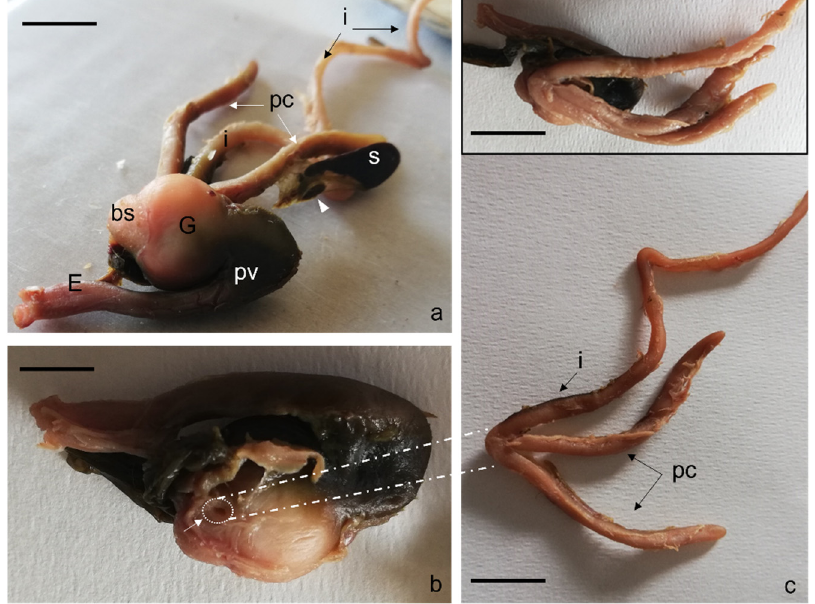
Figure 4. Gross anatomy. ( a ) Photograph of the right side of the gastrointestinal tract: esophagus (E), proventriculus (pv), gizzard (G), cranioventral blind sac (bs), spleen (s), accessory or supernumerary spleen (arrowhead), pyloric appendages (pc), intestine (i). ( b ) Photographs of the right side of gizzard: pyloric ostium (arrow) visible after intestine and pyloric appendages removal. ( c ) Isolated intestine (i) and pyloric appendages (pc), anatomical relationships of the intestine and the pyloric appendages with the gizzard (insert). Scale bar: 1